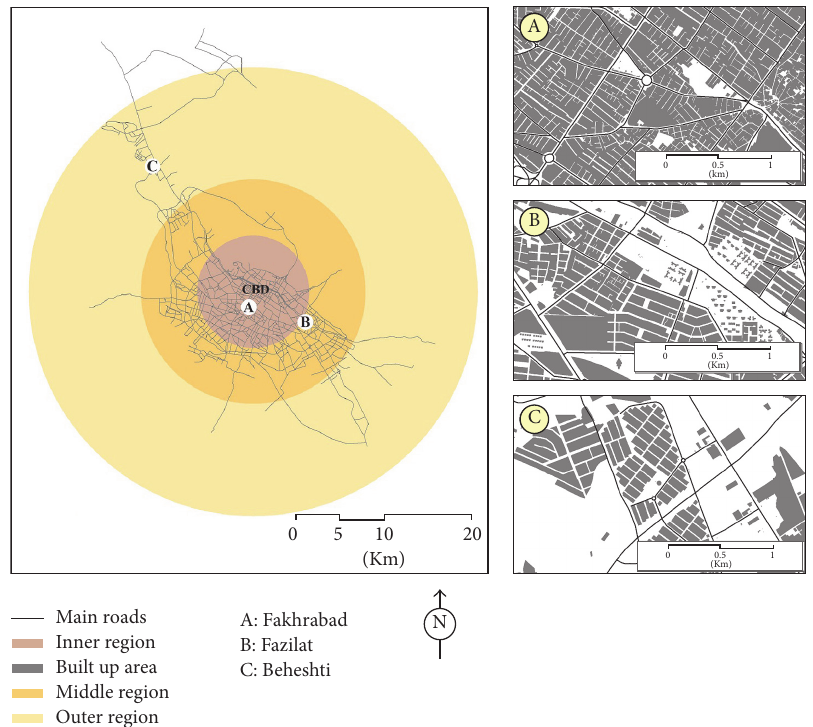
Figure 1: Shiraz metropolitan area and the three studied neighborhoods: (A) Inner (Fakhrabad); (B) Middle (Fazilat); (C) Outer (Beheshti).